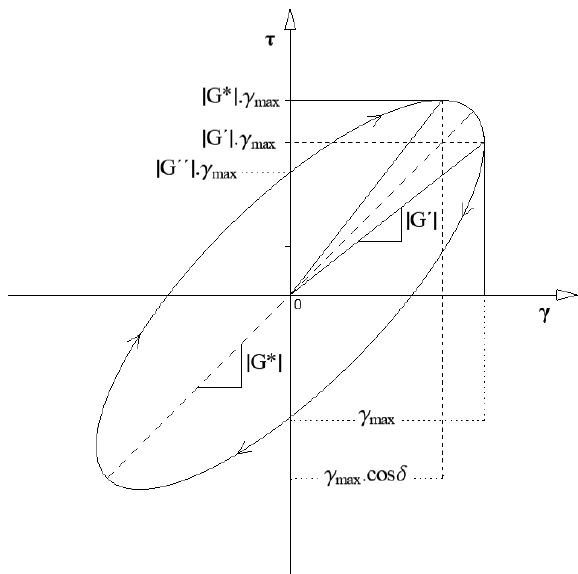
Fig. 7 Hysteresis loop showing stress-strain dependence in each loading cycle with its important points, (Lakes